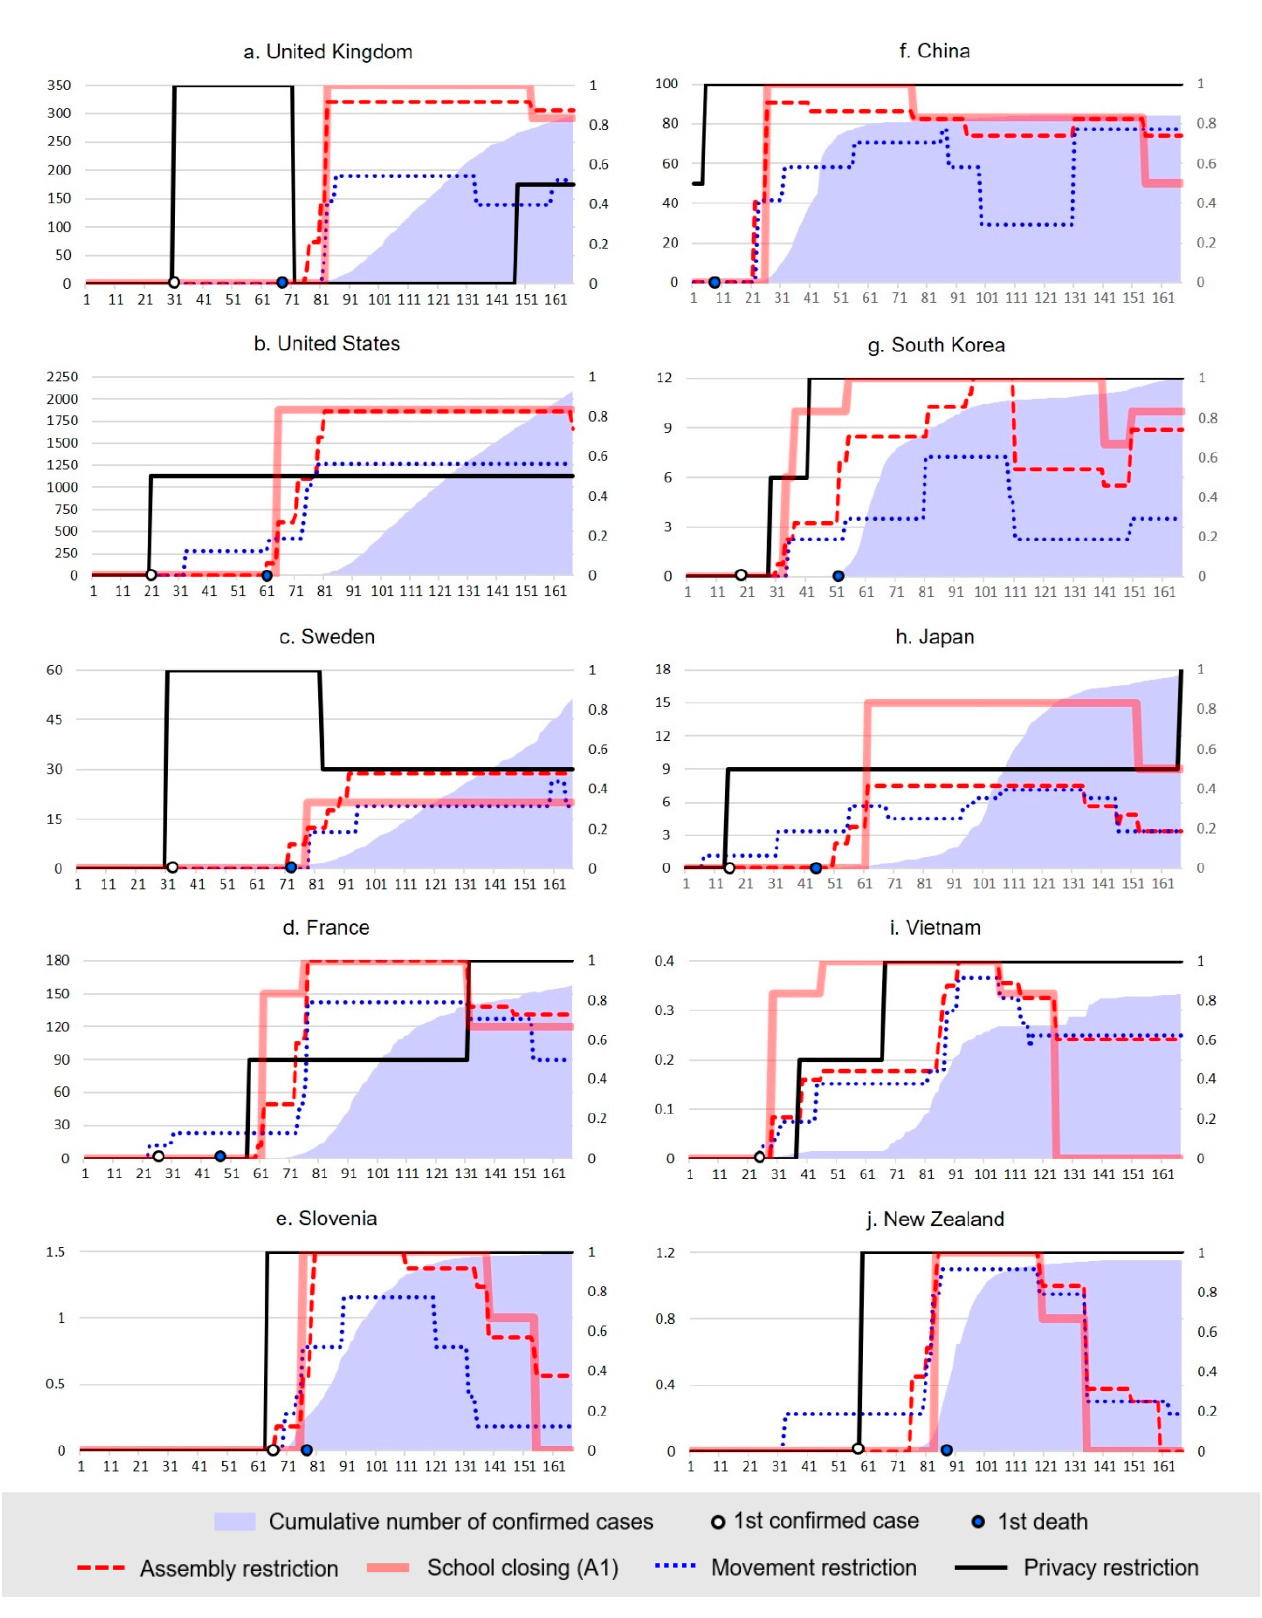
Figure 2. Changes in NPIs and cumulated number of confirmed cases of COVID-19 in the selected countries. The horizontal axis denotes the number of days from the 1 January 2020. The right vertical axis denotes the standardized score of NPIs. The left vertical axis denotes the number of confirmed cases of COVID-19; the unit of confirmed cases is a thousand people.